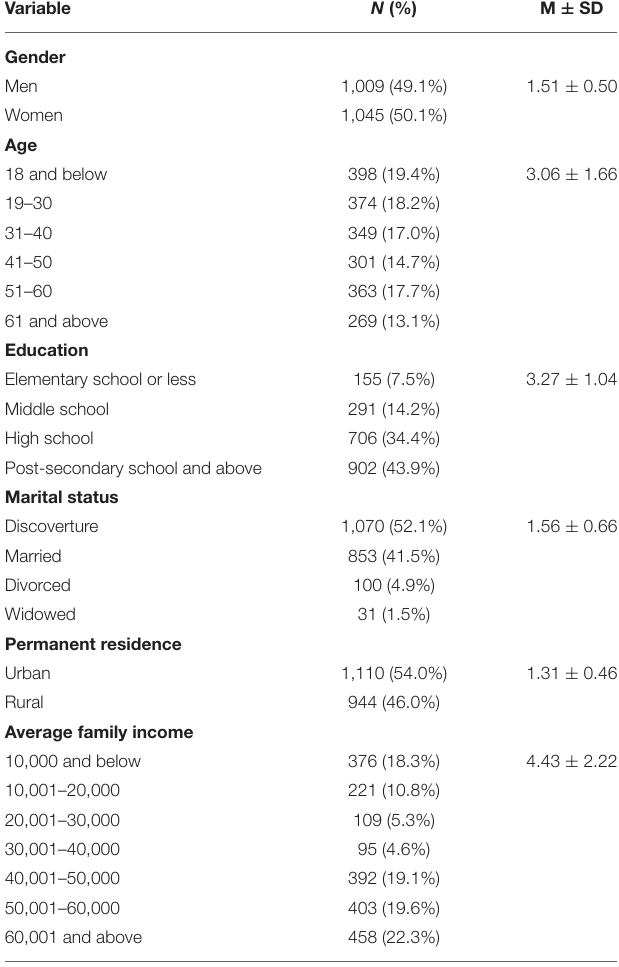
TABLE 1 | General characteristics of participants ( N =